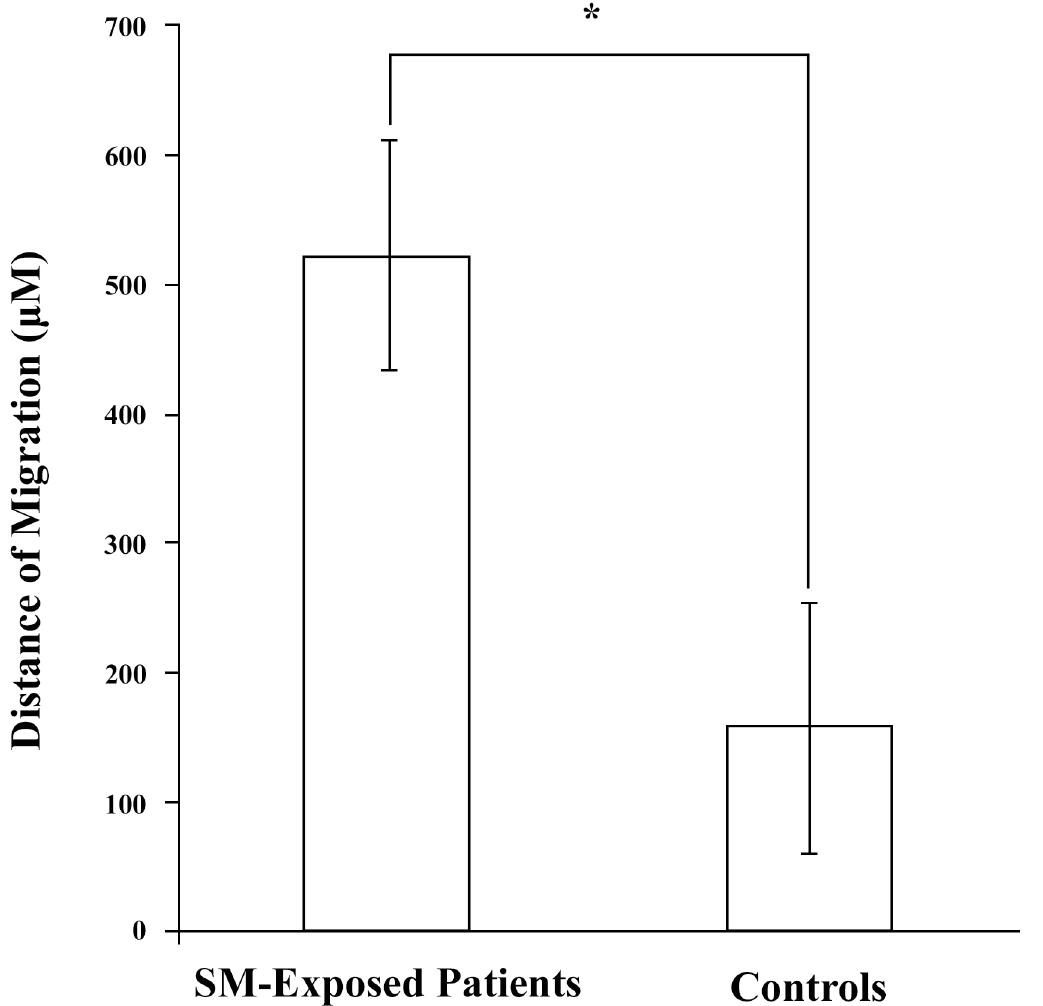
Fig 6. Cell migration. The migration distance of fibroblasts isolated from SM-exposed patients (n = 5) was significantly higher than the distance migrated by controls (n = 4); * p < 0.05. Abbreviations: SM sulfur